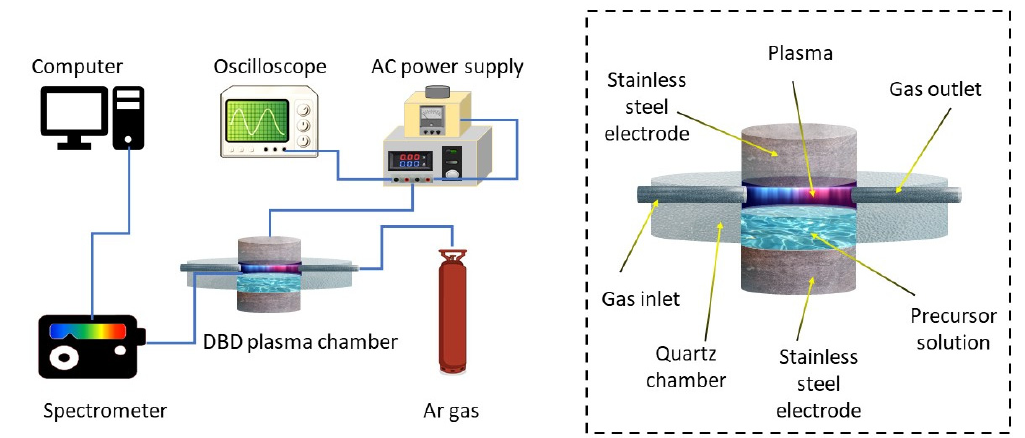
Figure 1. Schematic diagram of the DBD plasma setup used for the Ag nanoparticles synthesis. Inset: detailed diagram of the DBD plasma system .